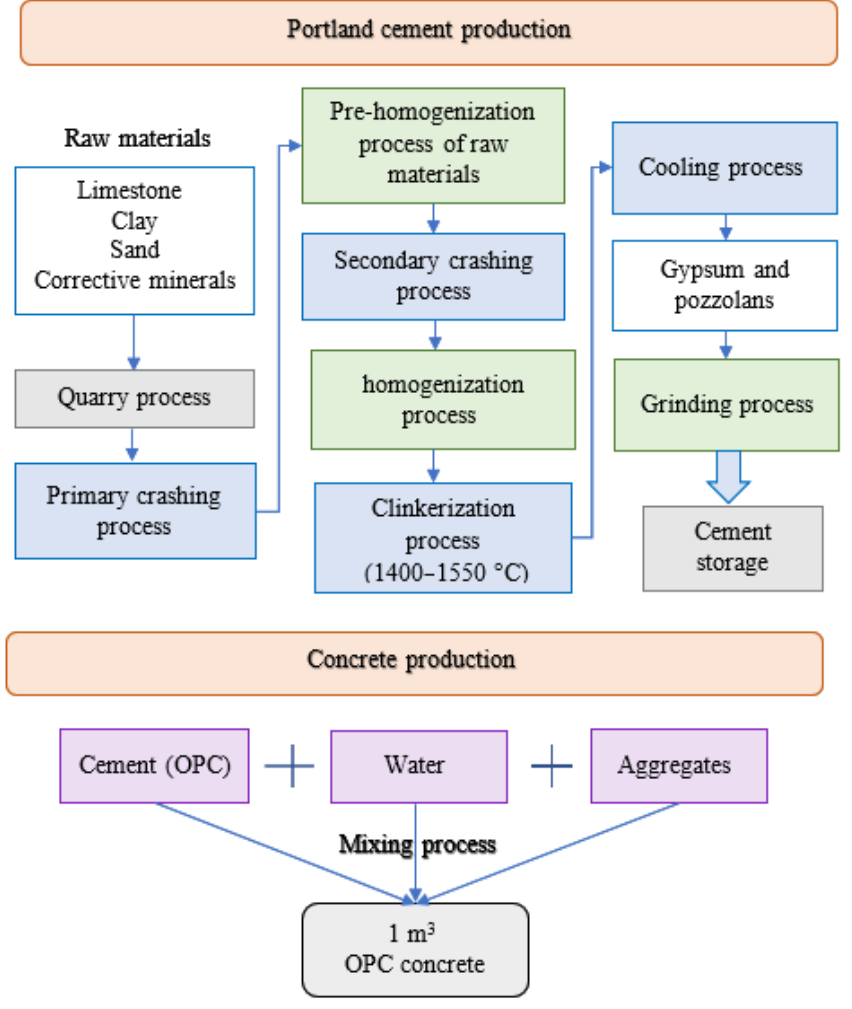
Figure 5. Life cycle stages from cradle to gate for OPC concrete production.